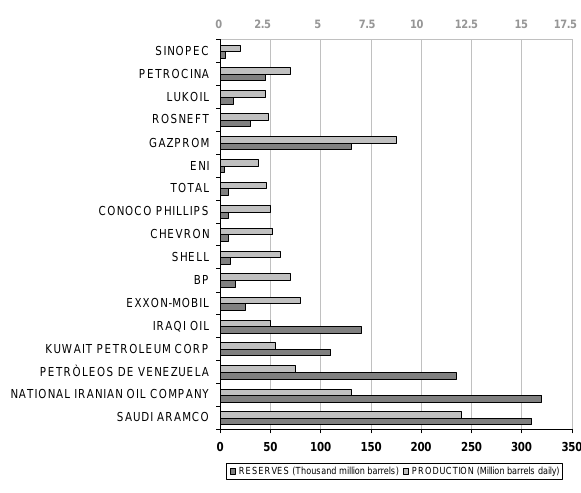
Figure 1: World’s Largest Oil Companies – 2009